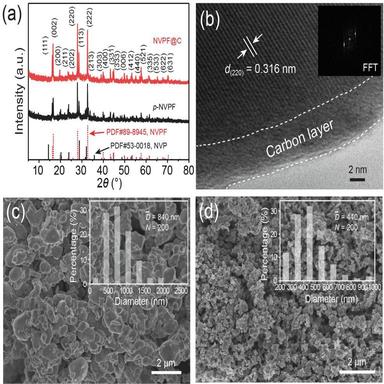
(Color online) Structural and morphology characterizations of NVPF@C and p-NVPF. (a) The XRD patterns of NVPF@C and p-NVPF. (b) HRTEM image of NVPF@C showing the ultra-uniform carbon coating. Inset in (b) is the corresponding FFT diffraction pattern. (c, d) SEM images and the counting-statistical size distributions (insets) of (c) p-NVPF and (d) NVPF@C.